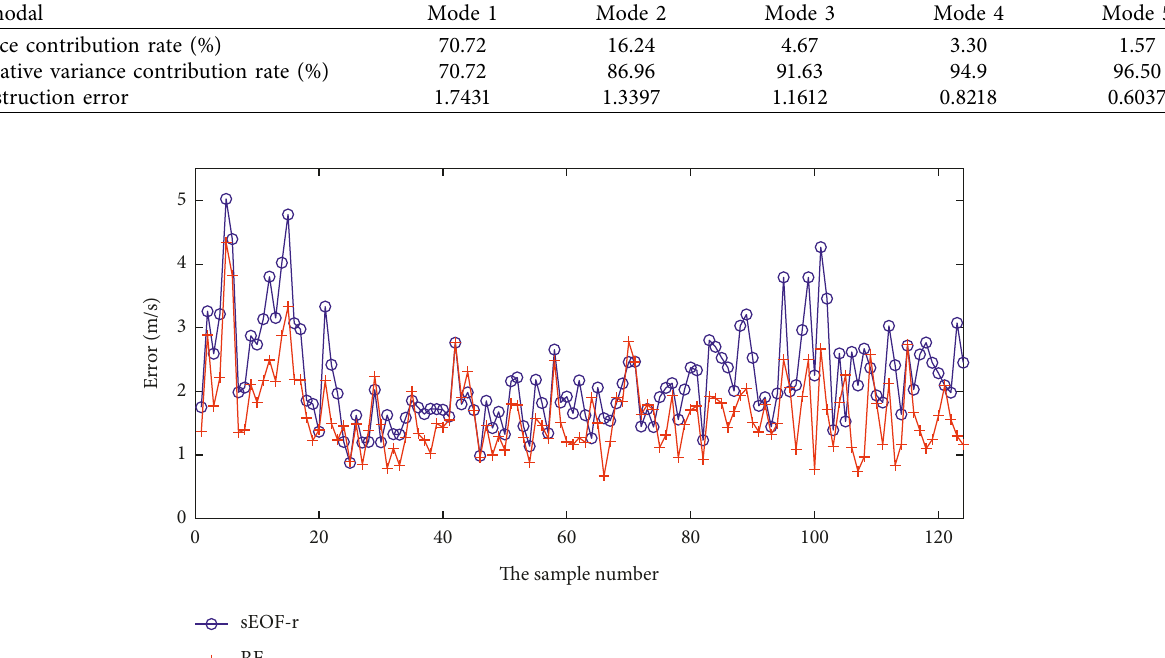
Figure 5: The error between the reconstructed and measured profiles by the sEOF-r and RF models.